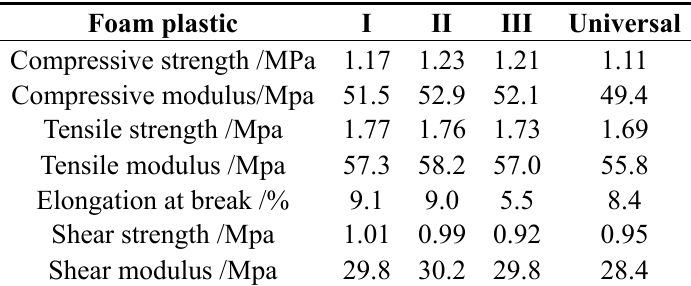
Table 4. Mechanical properties of foam